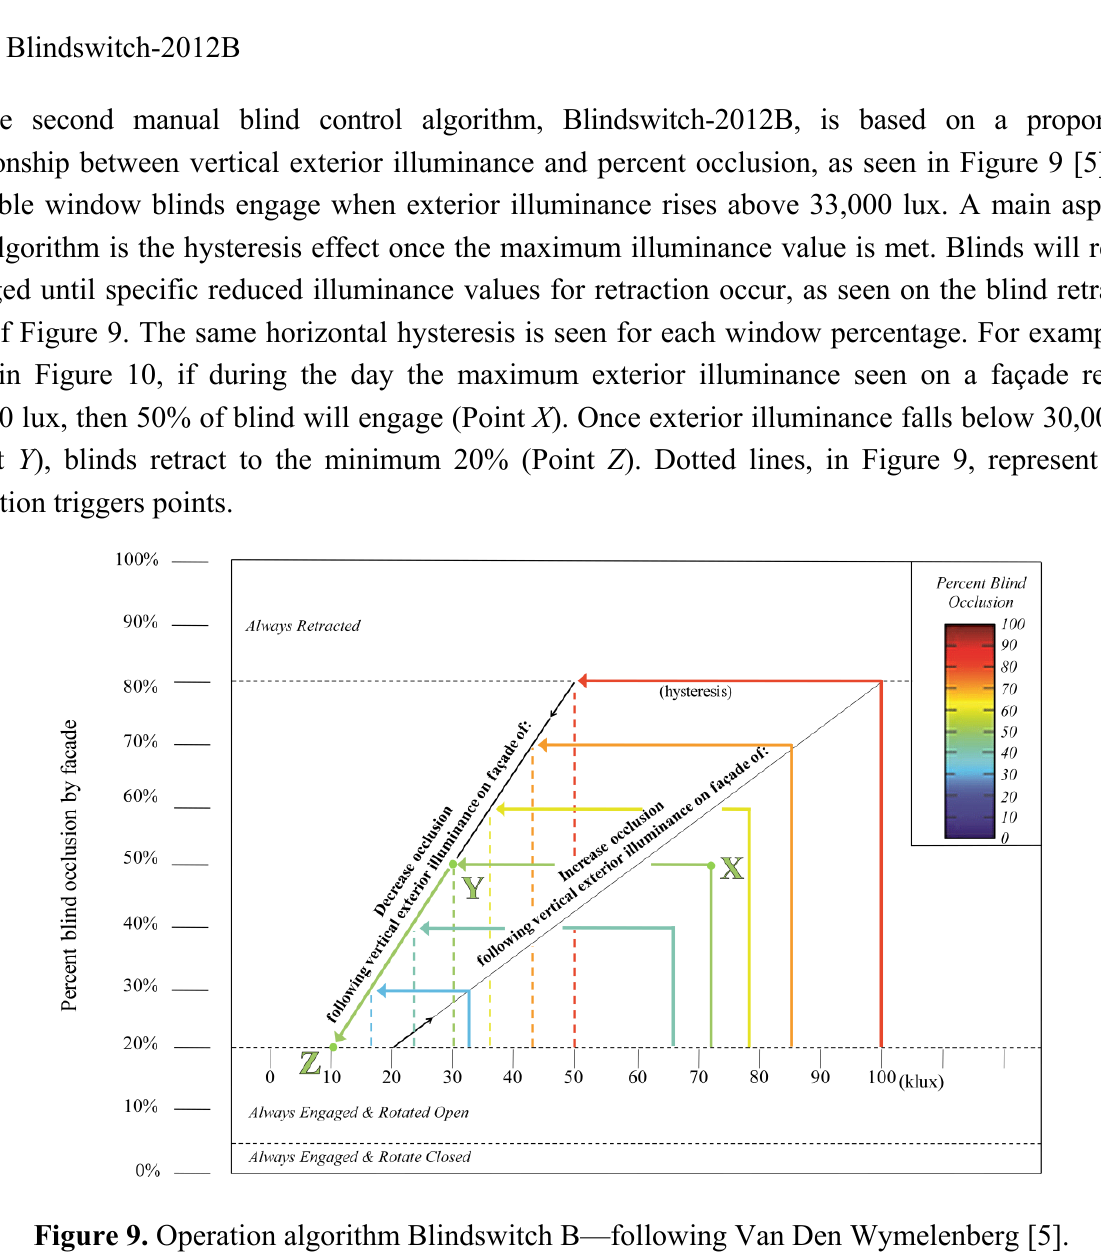
Figure 9. Operation algorithm Blindswitch B—following Van Den Wymelenberg